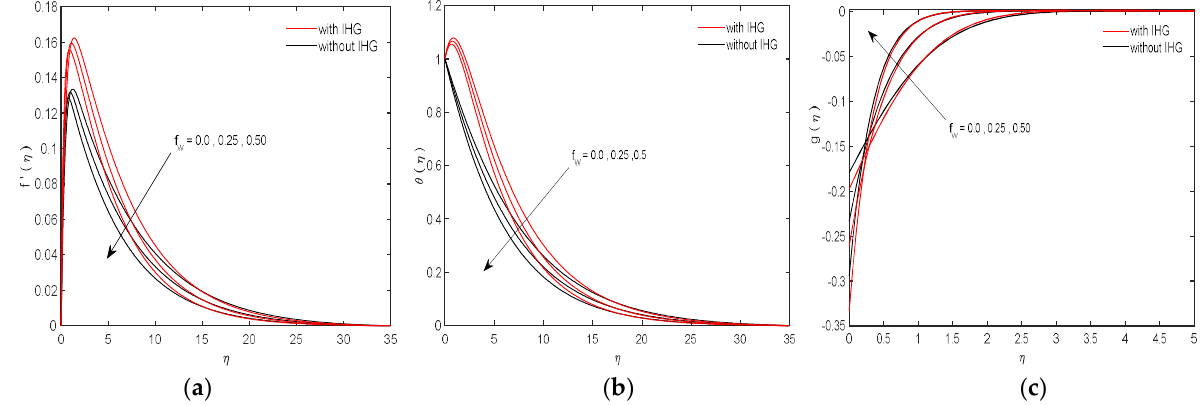
Figure 3. The effect of the suction parameter f w on the ( a ) velocity profile, ( b ) temperature profile and ( c ) angular velocity profile for R = 0.5, M = 2, λ = 0.5, c = 1, B = 0.2, φ 1 = φ 2 = 0.05, Da = 1; Rd = 1, n = 0.5.